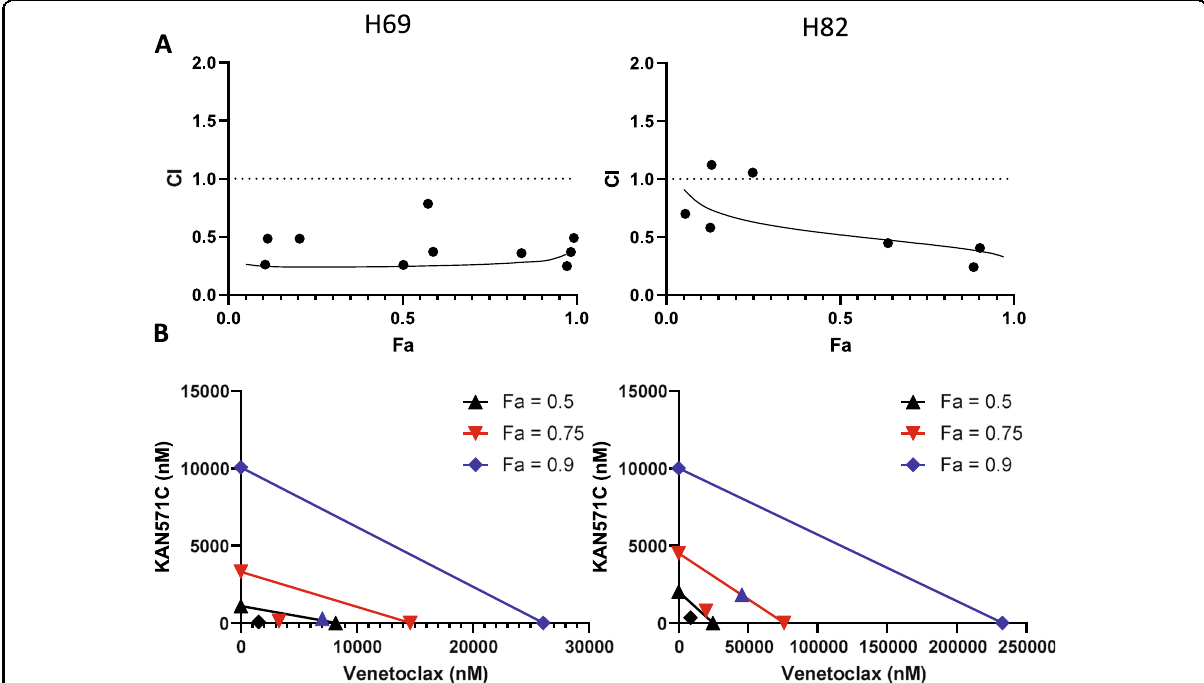
Fig. 4 KAN0441571C and venetoclax display synergy in causing SCLC cell line death. A Combinatorial index (CI) values across F a in H69 and H82 cells, where Fa is percentage cell death. Synergy is de fi ned by CI < 1, additivity 1 <CI < 1.5, antagonism CI > 1.5. Combo2 points in H69 graph are from an additional experiment combined with the initial experiment due to initial points being clustered at high F a values. B Isoboles at 3 Fa values in H69 a nd H82 cells, where Dose A is de fi ned as KAN0441571C and Dose B is venetoclax. Synergy is de fi ned by a combination point below the isobole, additivity a point on the isobole, and antagonism a point above the